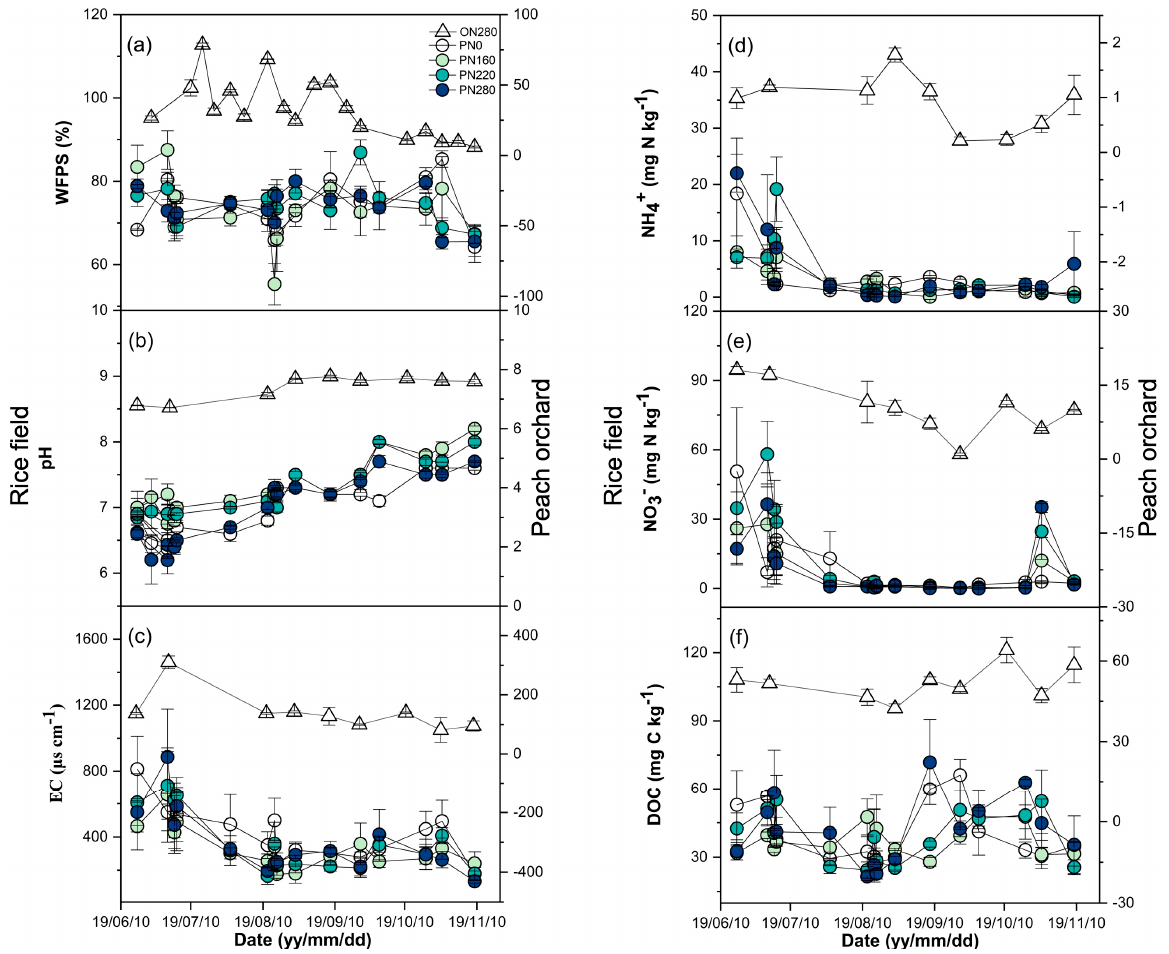
Figure 3. Seasonal dynamics of ( a ) water-filled pore space (WFPS), ( b ) pH, ( c ) electrical conductivity (EC), ( d ) ammonium (NH 4+ ), ( e ) nitrate (NO 3 − ), and ( f ) dissolved organic carbon (DOC) concentra- tions. Values are means ± SE ( n = 3). The left y-axis is for the rice field, and the right y-axis is for the peach orchard.